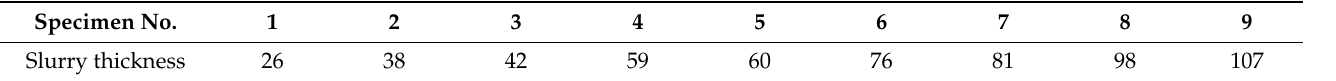
Figure 2. Slurry aluminizing process. Table 2. Slurry thickness values on different specimens ( µ Table 2. Slurry thickness values on different specimens ( μ m).